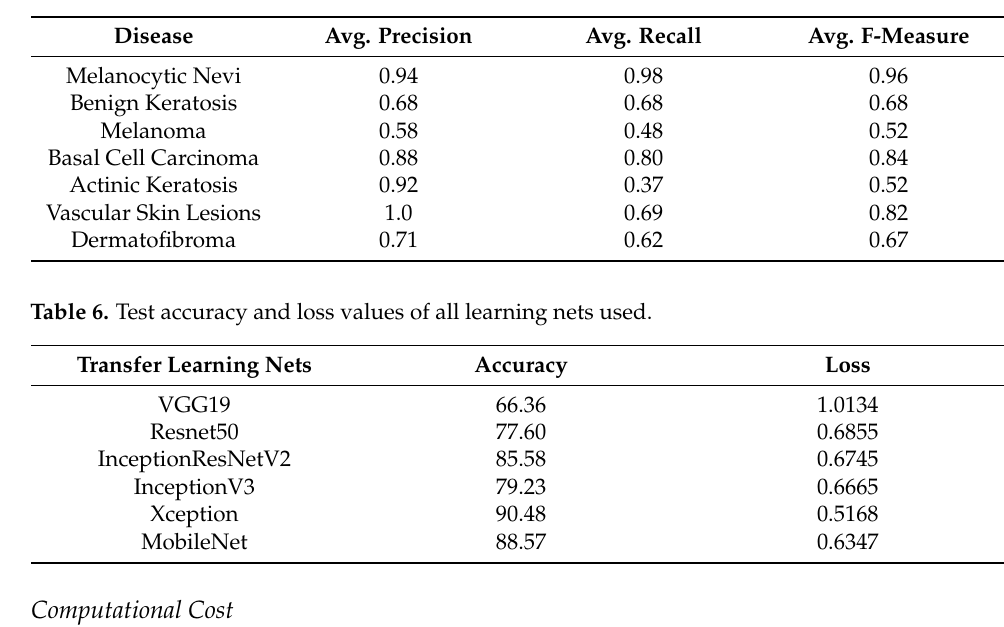
Table 5. Xcpetion Net precision, recall, and F1-Score values.